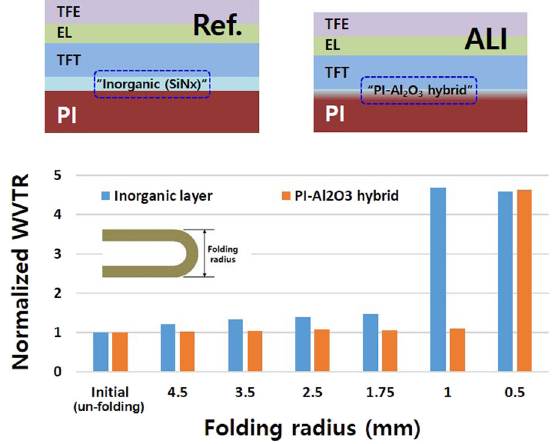
Fig. 5 The results of folding test. Flexibility test result comparison between the PI-Al 2 O 3 hybrid barrier nanolayer and the inorganic layer: a folded characteristics; b normalized WVTR results according to folding radius after folding tests.